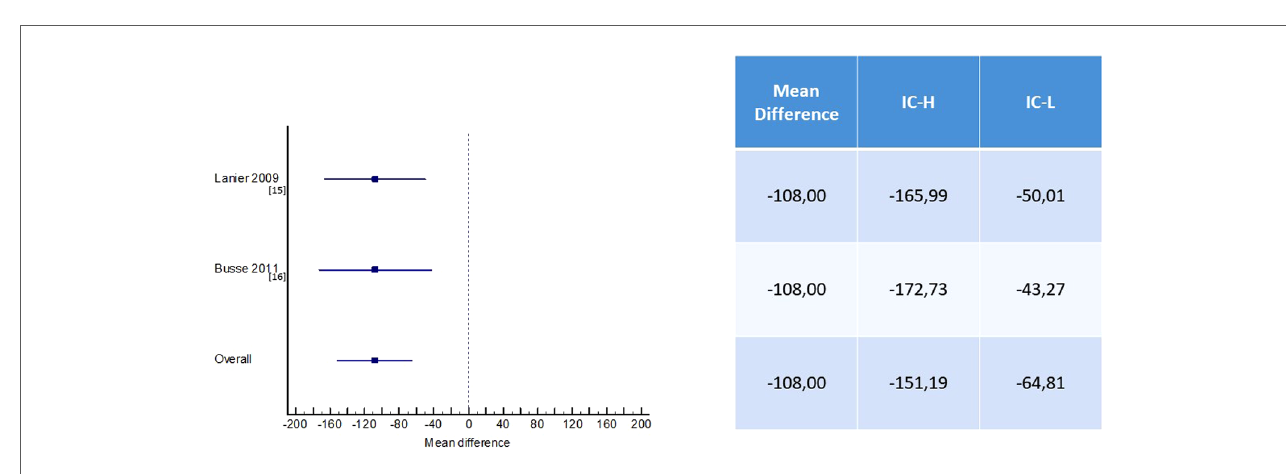
FIGURE 3 Effect of omalizumab vs. placebo on reduction in ICS